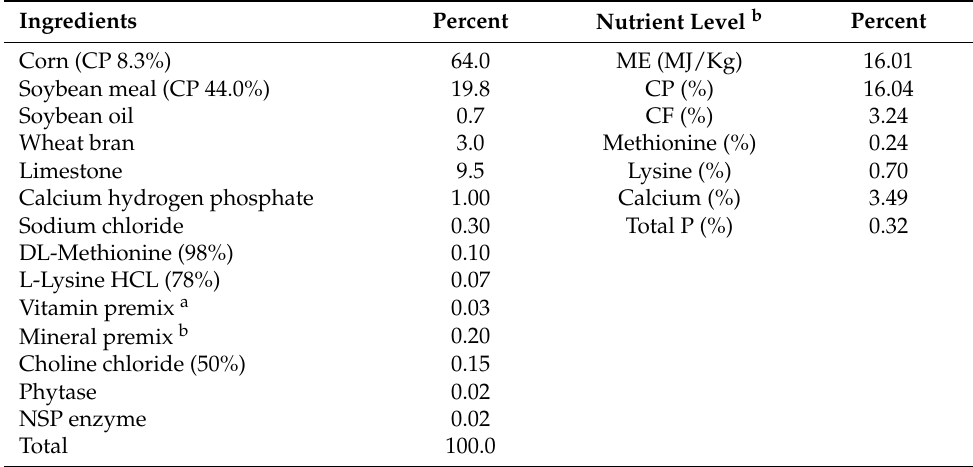
Table 1. Ingredients and nutrient composition of basal diet.